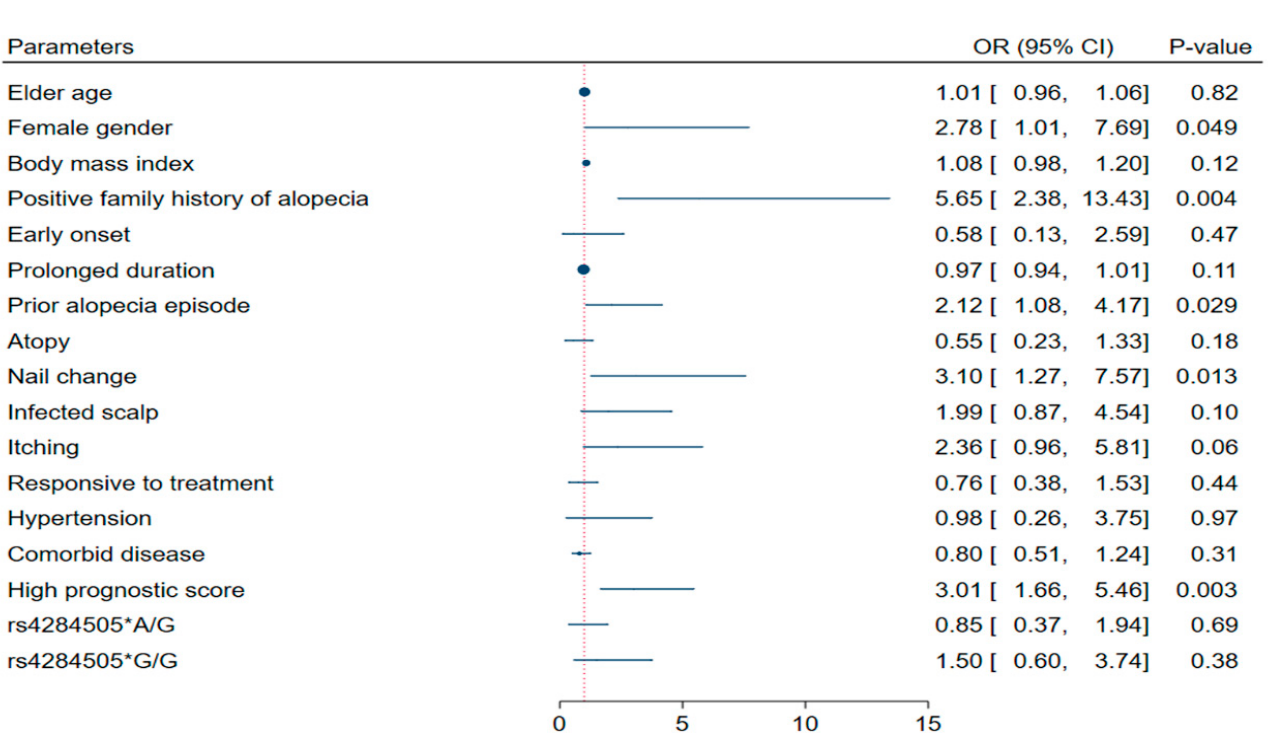
Figure 4. Independent predictors of severe alopecia disease. Multivariate analysis was conducted using binary logistic regression (enter method). Significantly correlated variables with each other were removed after testing by Pearson’s correlation test. The model correctly classified 64.5% of the observations; the Hosmer and Lemeshow test for goodness-of-fit was 0.203, indicating that the model was good. OR: odds ratio, CI: confidence interval, BMI: body mass index, FH: family history, TTT: treatment, and AA: alopecia areata.